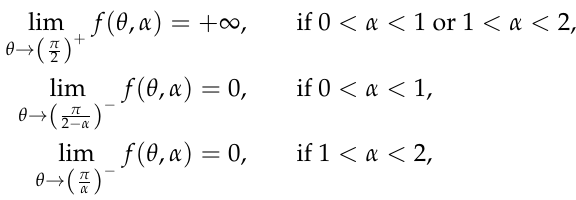
< θ < π 2 max { α ,2 − α }